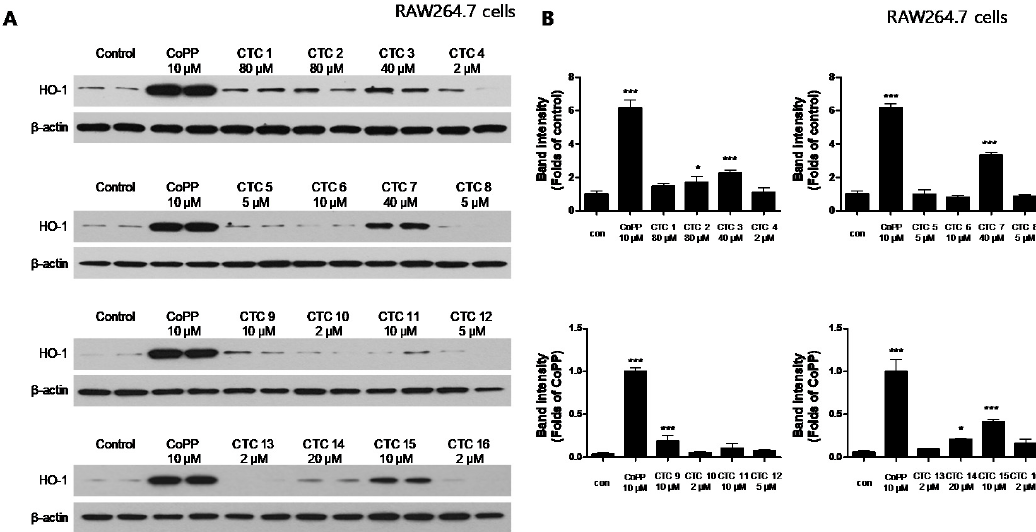
Figure 3. Effects of the sixteen C. tricuspidata compounds on the protein expression levels of HO-1 in RAW264.7 cells. ( A ) Cells were incubated for 12 h with the indicated concentration of each compound and analyzed using western blotting. ( B ) Band intensities were normalized to β -actin. CoPP (10 μ M) was used as a positive control. Data are presented as the mean ± standard deviation of four independent experiments. * p < 0.05, *** p < 0.001 when compared to the control group.